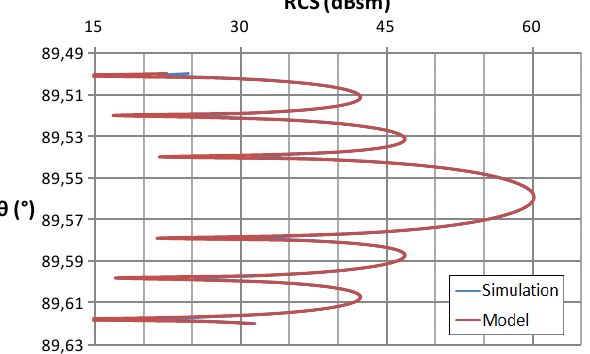
Figure 8. RCS pattern obtained by simulation vs. RCS values obtained by the proposed simplified model for the mast of wind turbine model 1 and frequency 5.65 GHz.